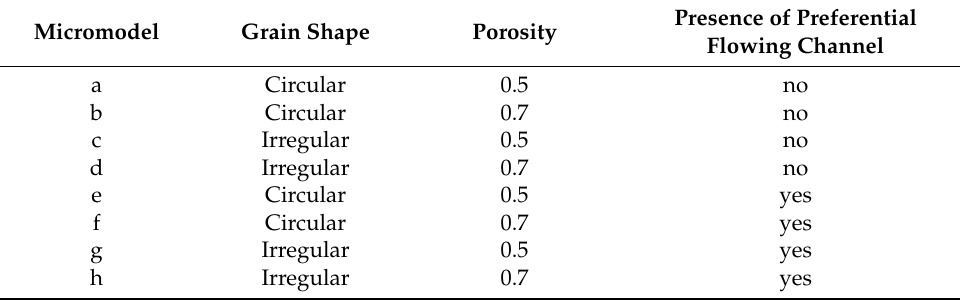
Table 3. Characteristics of the